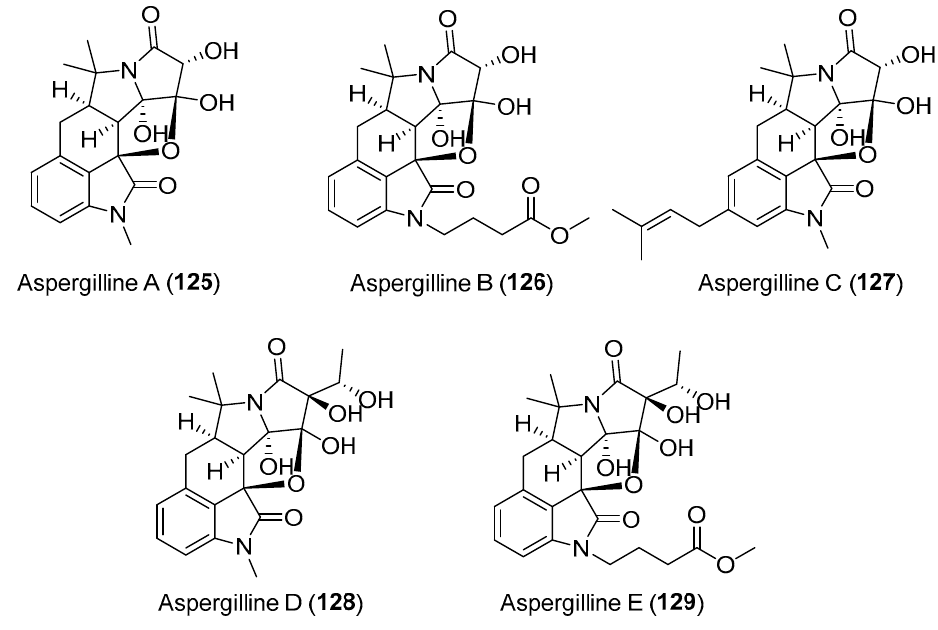
Figure 22. Structures of aspergillines A–E ( 125 – 129 ).